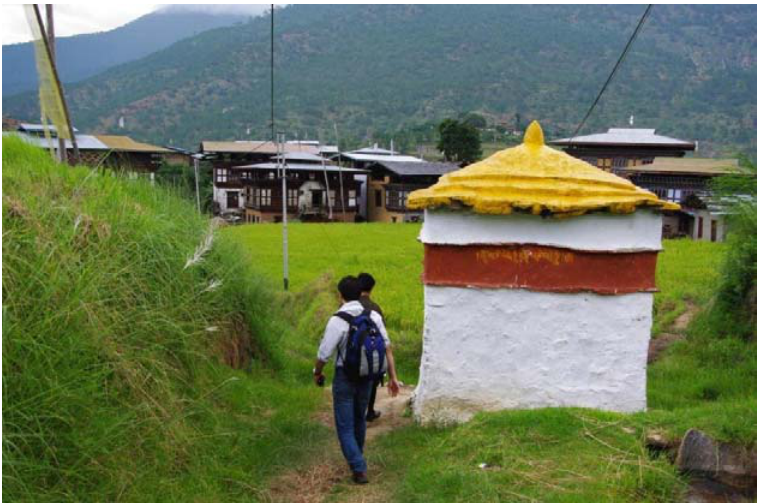
Figure 7. Trail to Chimi Lhakhang,